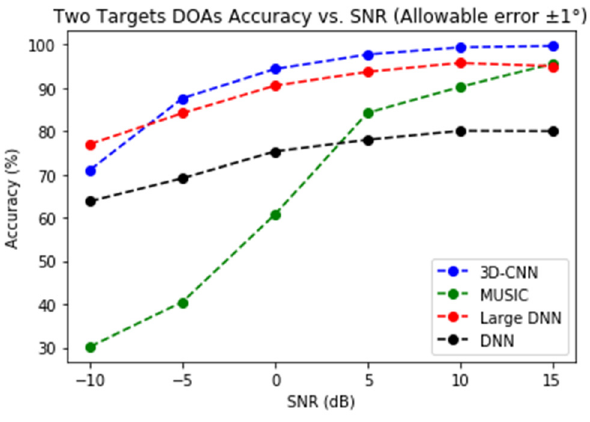
Figure 9. Accuracy of two-target DoA estimation, with an allowable error of (cid:3399) 1°.